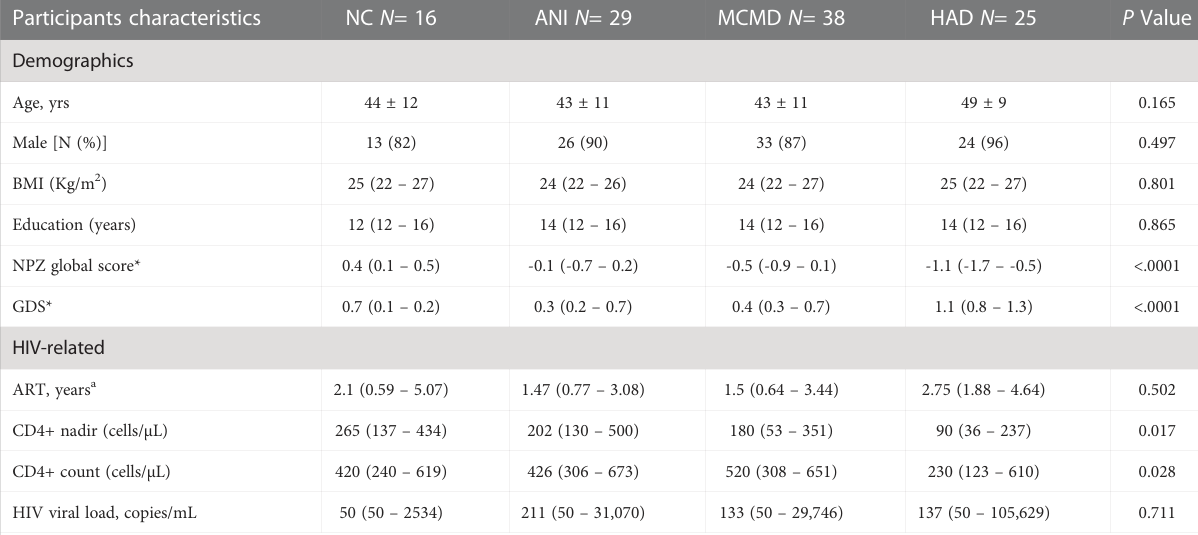
TABLE 1A Demographic and clinical characteristics of HIV-infected participants.